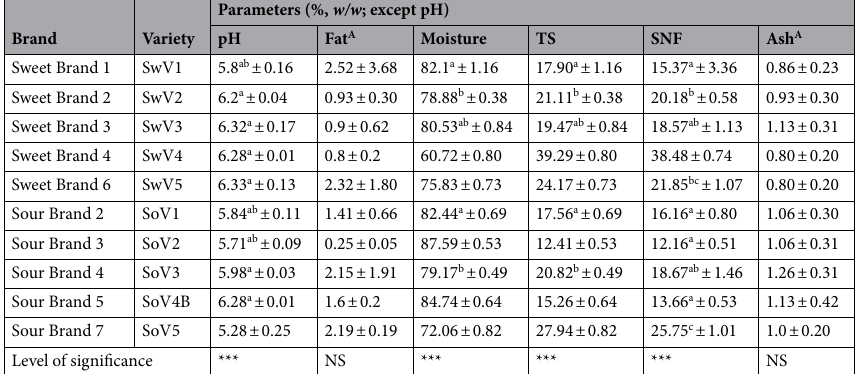
Table 1. Biochemical parameters of Bangladeshi yogurt of different brands and tastes. TS = Total solid, SNF = Solid-not-fat, SwV = Sweet variety, SoV = Sour variety, Mean values with different superscripts ( a, b, c, ab, bc ) in the same column differed significantly while those left with no superscripts differed with all, A = No mean value showed any significant difference among each other hence were left single i.e. without any superscripts, *** = Significant at 5% level ( P < 0.05), NS = Non-significant, The values of all parameters were recorded as mean ±